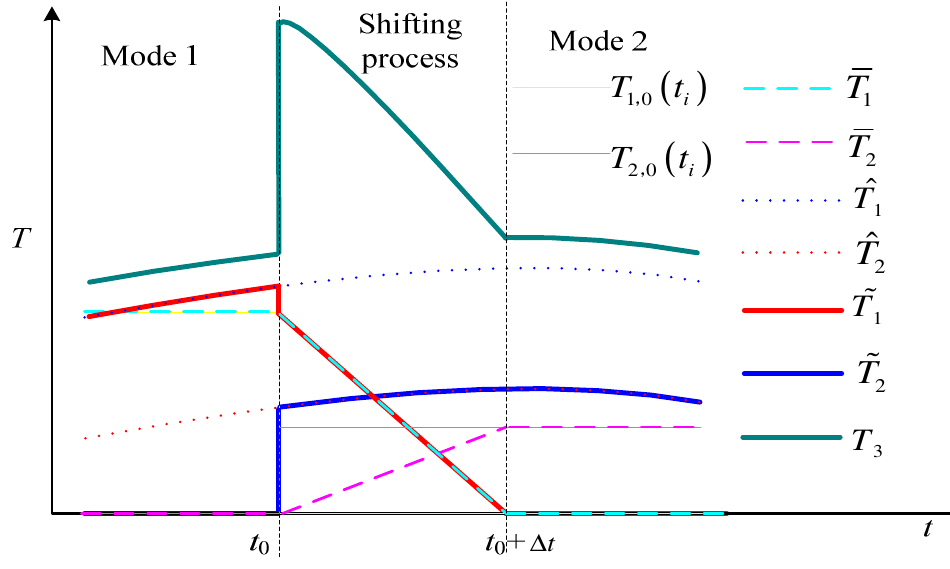
Figure 8. Schematic of mode shifting based on CFBDCS.